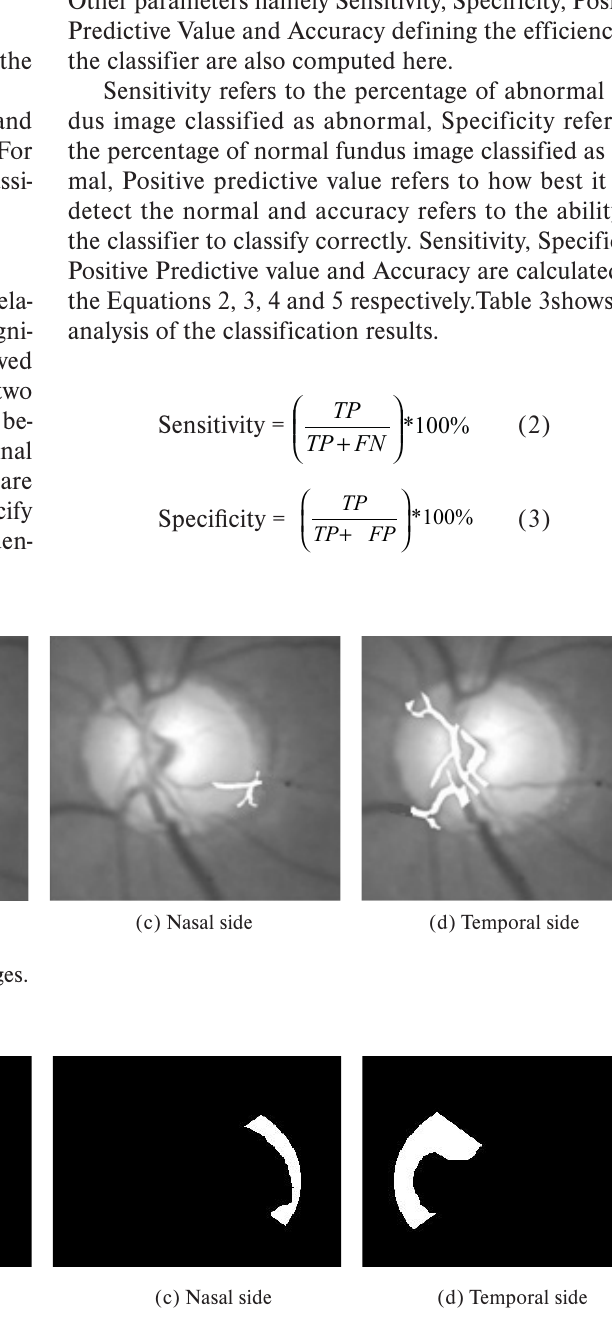
Fig. 4. Segmented abnormal neural retinal RIM